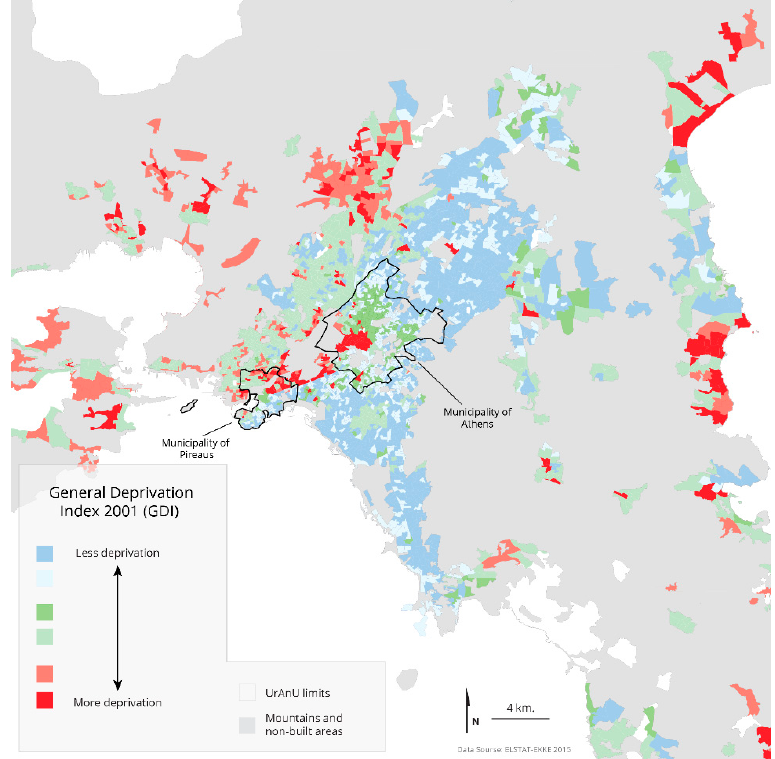
Figure 4. Clusters of deprivation in Athens (2001).